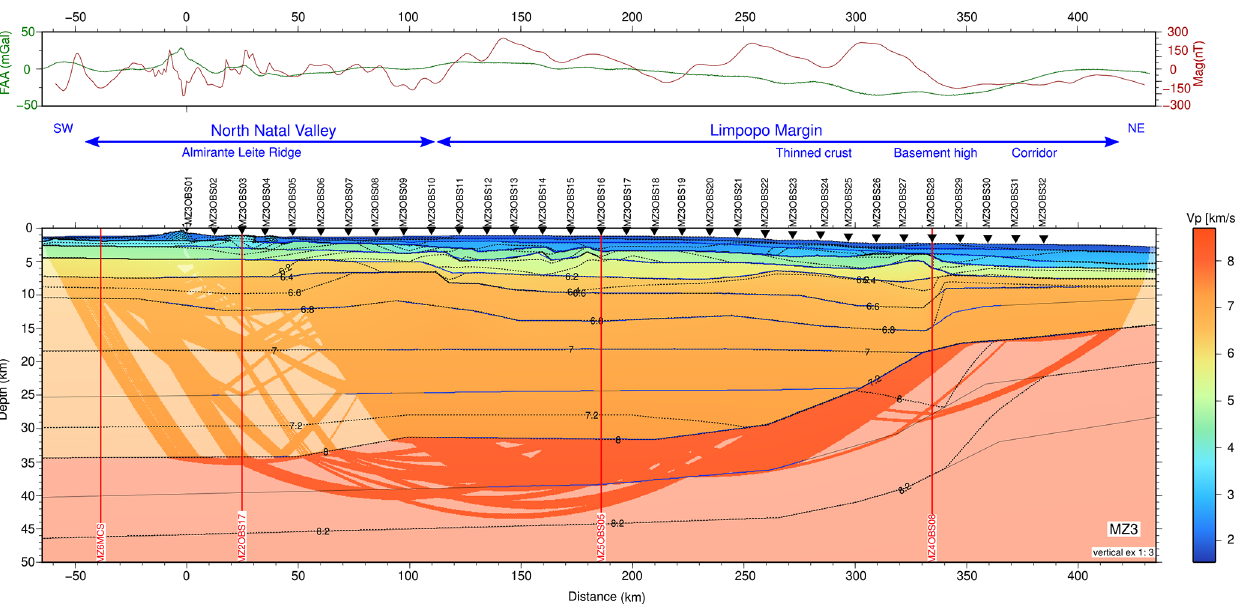
Figure 13. MZ3 final P-wave velocity model with region constrained by seismic rays highlighted. Blue lines indicates where wide-angle reflections constrain the model interfaces that are otherwise shown with black lines. Inverted black triangles mark OBS positions. Vertical exaggeration is 1 :